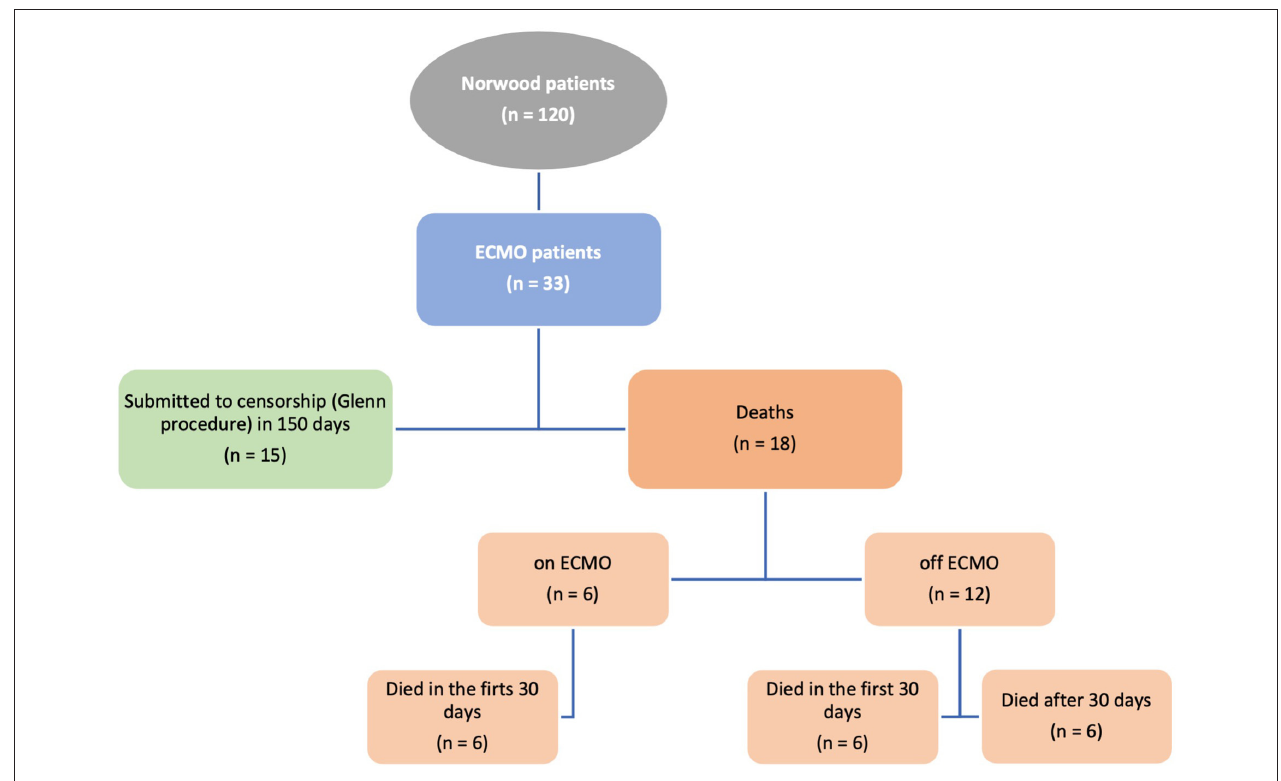
FIGURE 1 | Flow chart of HLHS patients receiving ECMO assistance.